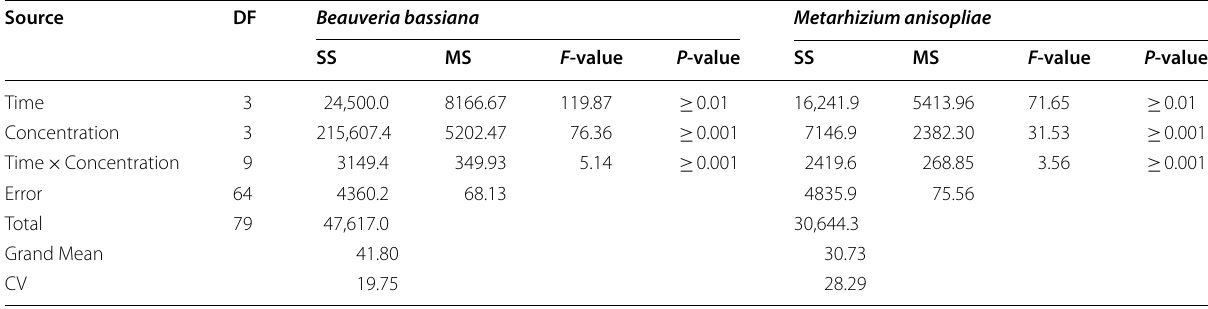
P 0.001 (highly significant) and P ≥